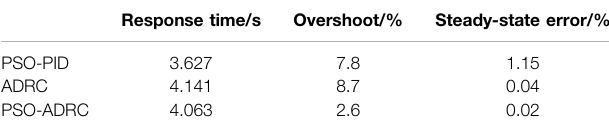
TABLE 3 | Tracking effect with internal